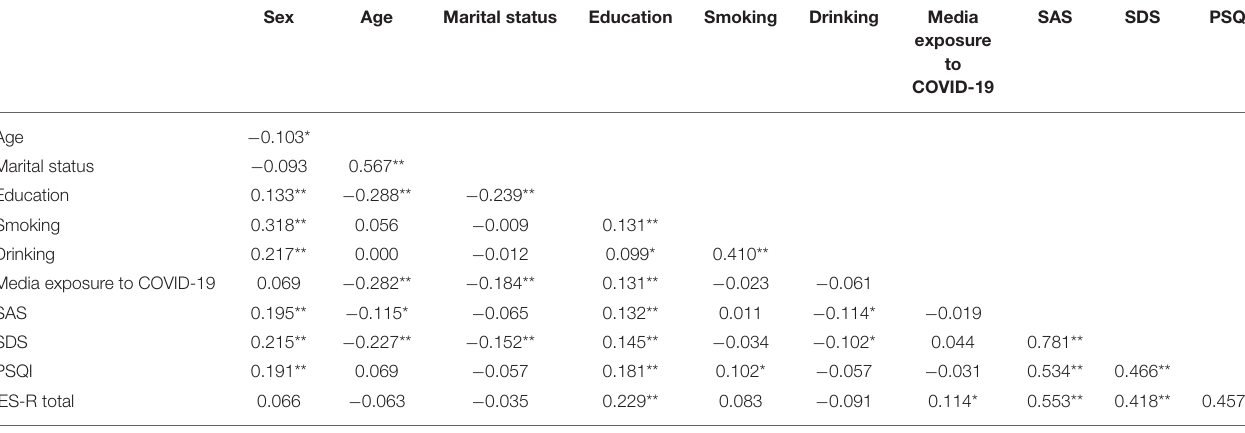
TABLE 3 | Correlations between demographic characteristics and clinical variables of depressed group. Sex Age Marital status Education Smoking